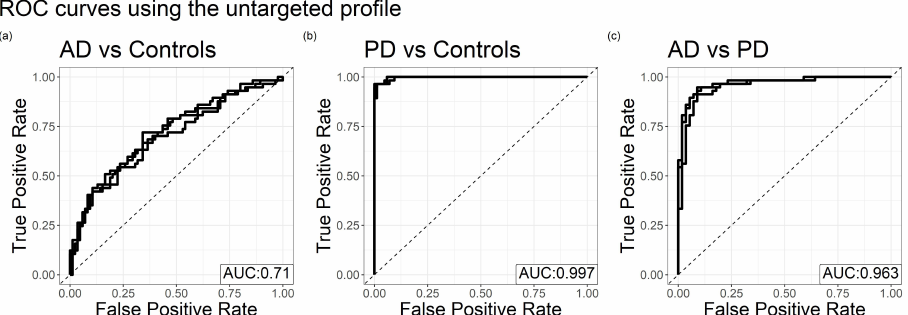
Figure 2. Receiver Operating Characteristic (ROC) Curves for binomial elastic net regressions classifying ( a ) controls against subjects with AD, ( b ) controls against subjects with PD, and ( c ) subjects with AD against subjects with PD. Solid lines represent models formed using each of the five missing data imputed datasets. The dotted y = x line represents the ROC curve under a model which makes predictions at random. The average Area Under the Curve (AUC) across the five ROC curves is displayed in the bottom right.